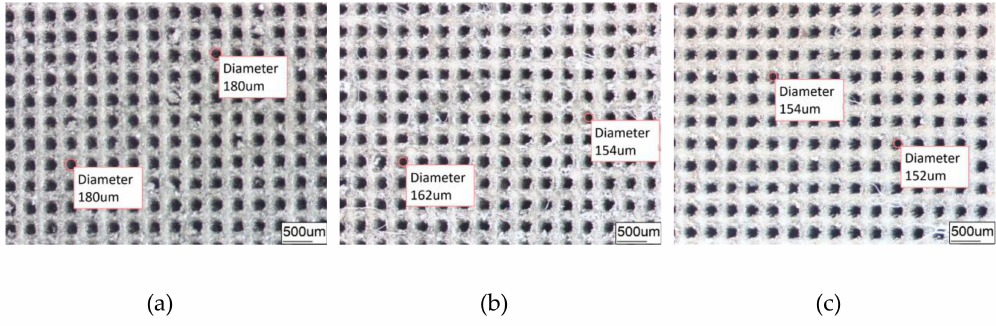
Figure 4. Dimple surface texture morphology obtained under di ff erent conditions. ( a ) DST samples; ( b ) DST / CE (Ni) samples; ( c ) DST / CE (Ni-1.5Gr)